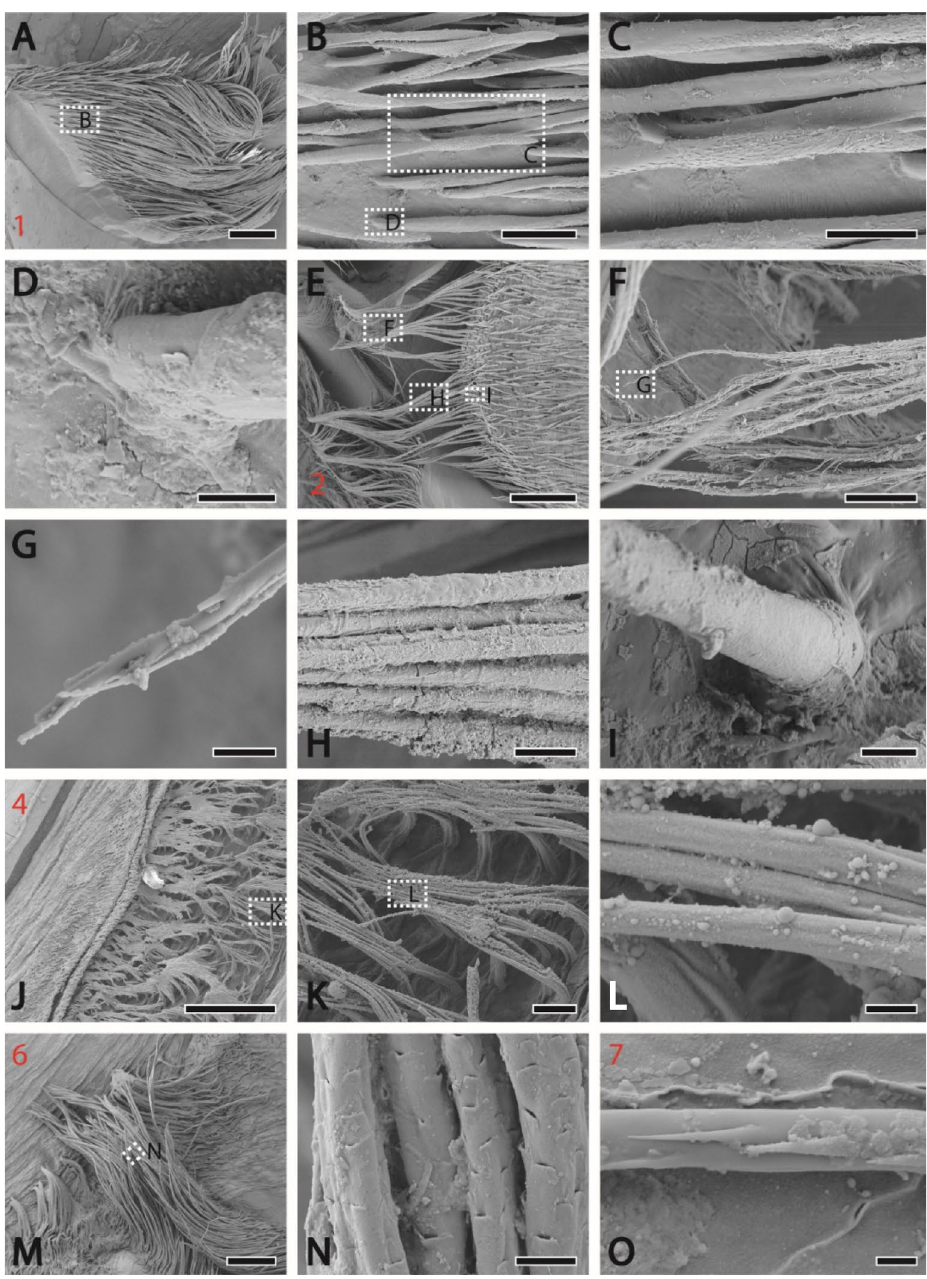
Figure 3. SEM images of the setae from distinct localities (the locality number is highlighted in red). ( A ) Presumably cuspidate setae with bold shaft and tip bearing small projections from the locality 1 with magnifications ( B )–( D ). ( D , I ) Attachment of the setae with the membrane; no socket could be seen. ( E ) Setae [also at high magnifications ( F )–( I )] bearing long serrated setules (plumodenticulate setae), which agglomerated and formed a net, from the locality 2. ( J ) From the locality 4, long setae [with magnifications ( K )–( L )] without setules of denticles, clustering together forming mattes. ( M ) From the locality 6; long setae [at high magnification ( N )] bearing small scales (pappose setae). ( O ) Setae with small projections on the tip from the locality 7. Scale bars: A, E, 400 µm; B, 80 µm; C, F, 40 µm; D, 8 µm; E, H, K, 20 µm; F, 100 µm; G, L, 3 µm; I, N, 6 µm; J, 200 µm; K, 20 µm; M, 200 nm; O, 2